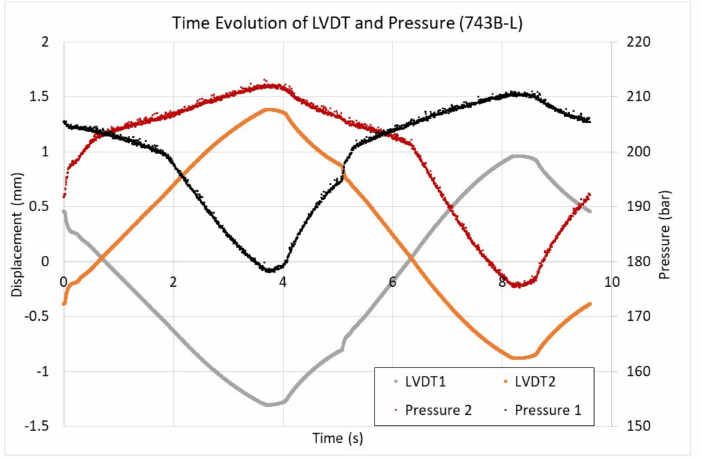
Figure 8. Time evolution of the displacement (LVDT) and the applied pressure for a spherical fatigue